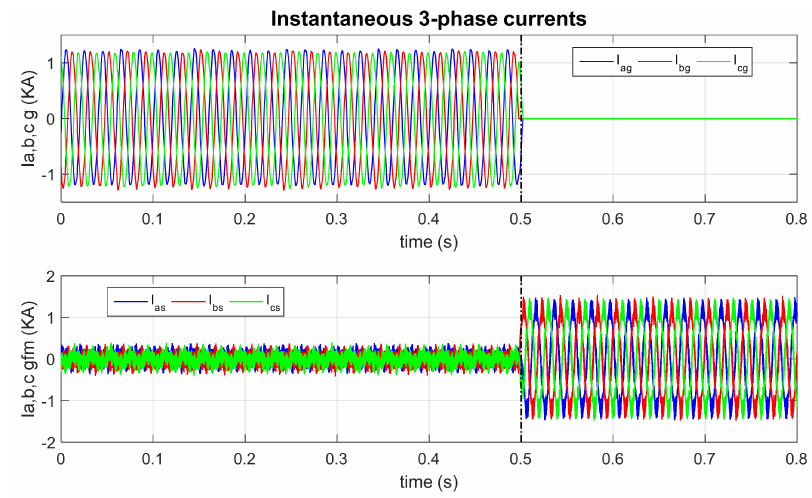
Figure 22. Instantaneous 3-phase currents during the transition to islanded mode.